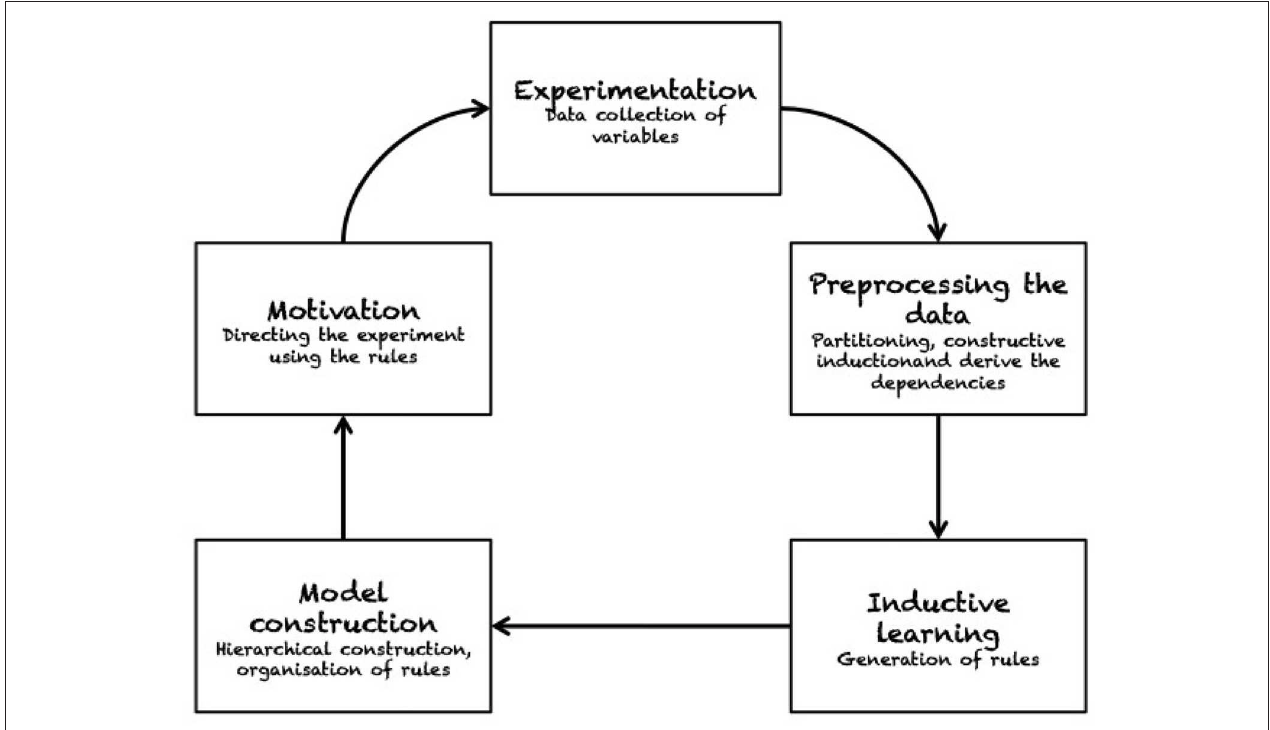
FIGURE 7 | The sequence of operations adopted by Zrimec and Mowforth (1991) to construct their causality learning model. The robot learns by interacting with the environment in an unsupervised fashion. The system can autonomously discover knowledge, as e.g., whether an action generates a push on an object. The “motivation” module guarantees that the system is driven toward acquiring more knowledge about the robot/environment interaction. Reproduced from Zrimec and Mowforth (1991)